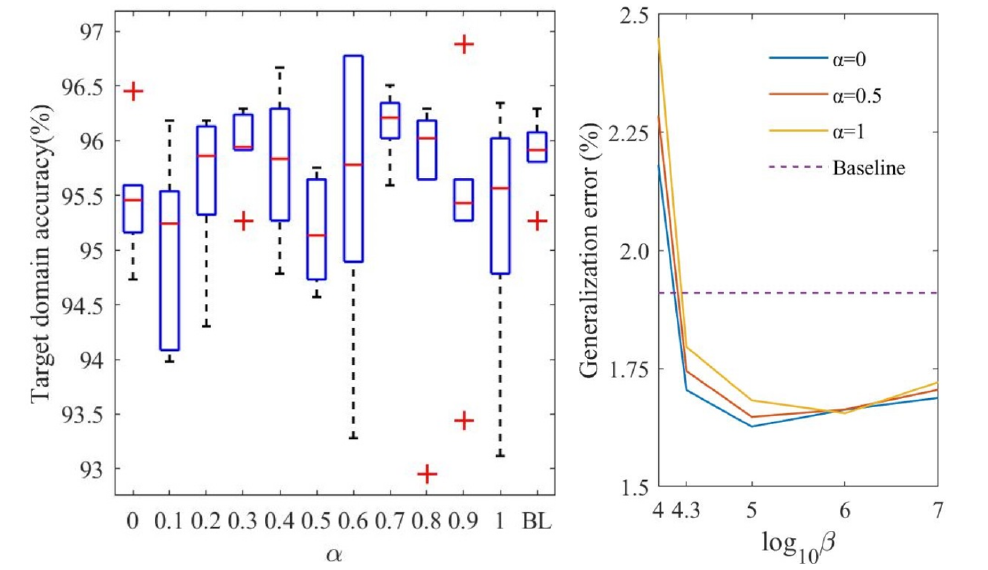
Figure 4. Left: Target domain accuracy by EIB in transferring MNIST to USPS. BL (baseline) is the DFA-MCD method. Right: SG on MNIST by